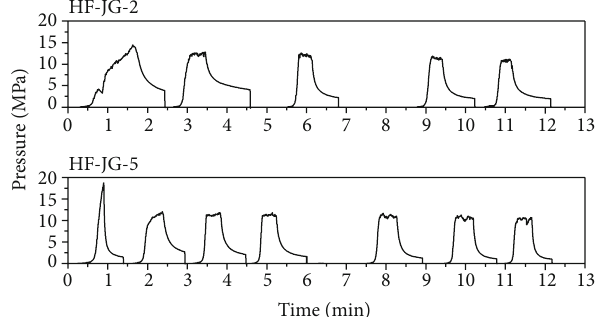
Figure 4: Typical experimental pressure-time curves corresponding to the HF tests of granite